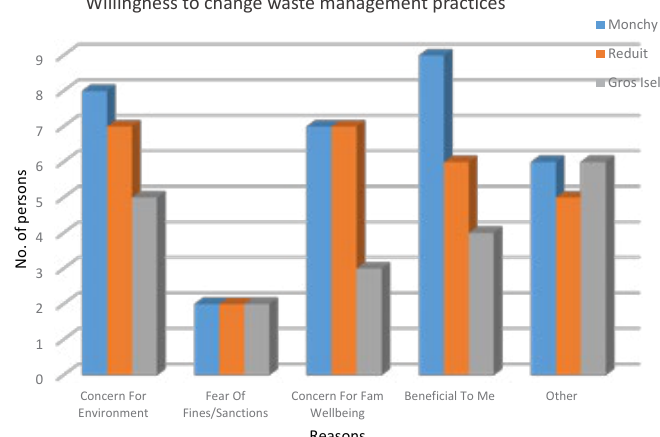
Fig. 9: Reasons impacting willingness to change waste management practices